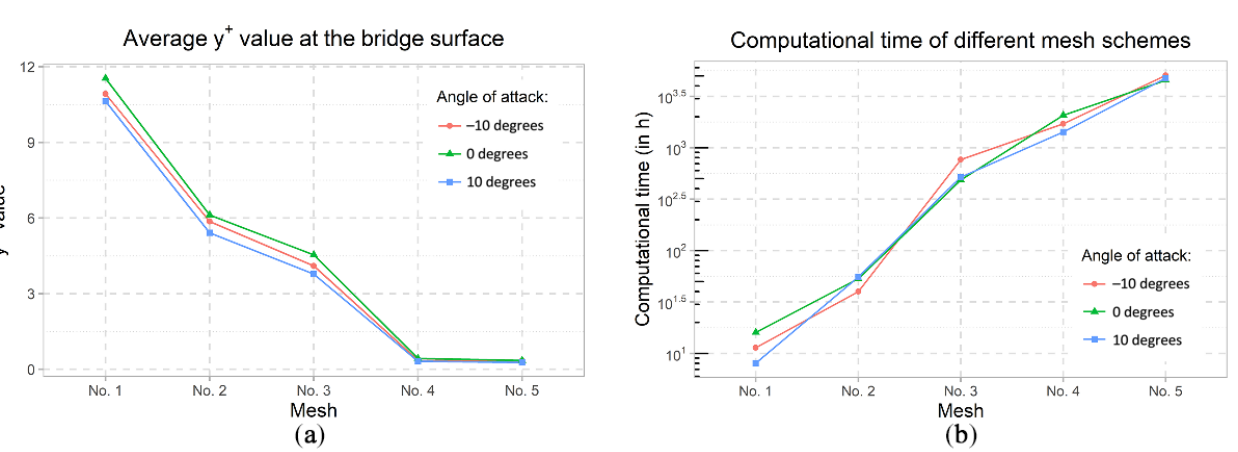
Figure 15. Effect of mesh density on y + value and computational time: ( a ) Average y + value at the bridge surface; ( b ) Computational time of different mesh.